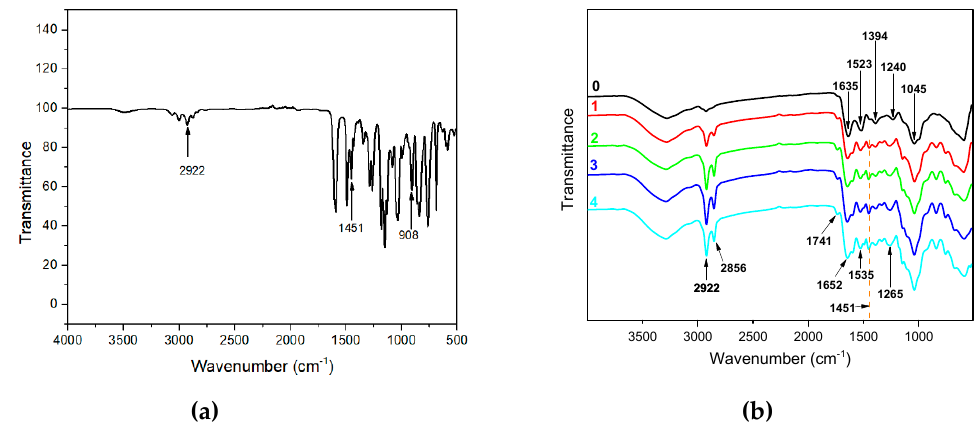
Figure 3. (a) FTIR spectra of DRE. (b) FTIR spectra of the different adhesives: 0 (SM adhesive), 1 Figure 3. ( a ) FTIR spectra of DRE. ( b ) FTIR spectra of the di ff erent adhesives: 0 (SM adhesive), (SM/DRE-2 adhesive), 2 (SM/DRE-4 adhesive), 3 (SM/DRE-6 adhesive), 4 (SM/DRE-8 adhesive). 1 (SM / DRE-2 adhesive), 2 (SM / DRE-4 adhesive), 3 (SM / DRE-6 adhesive), 4 (SM / DRE-8